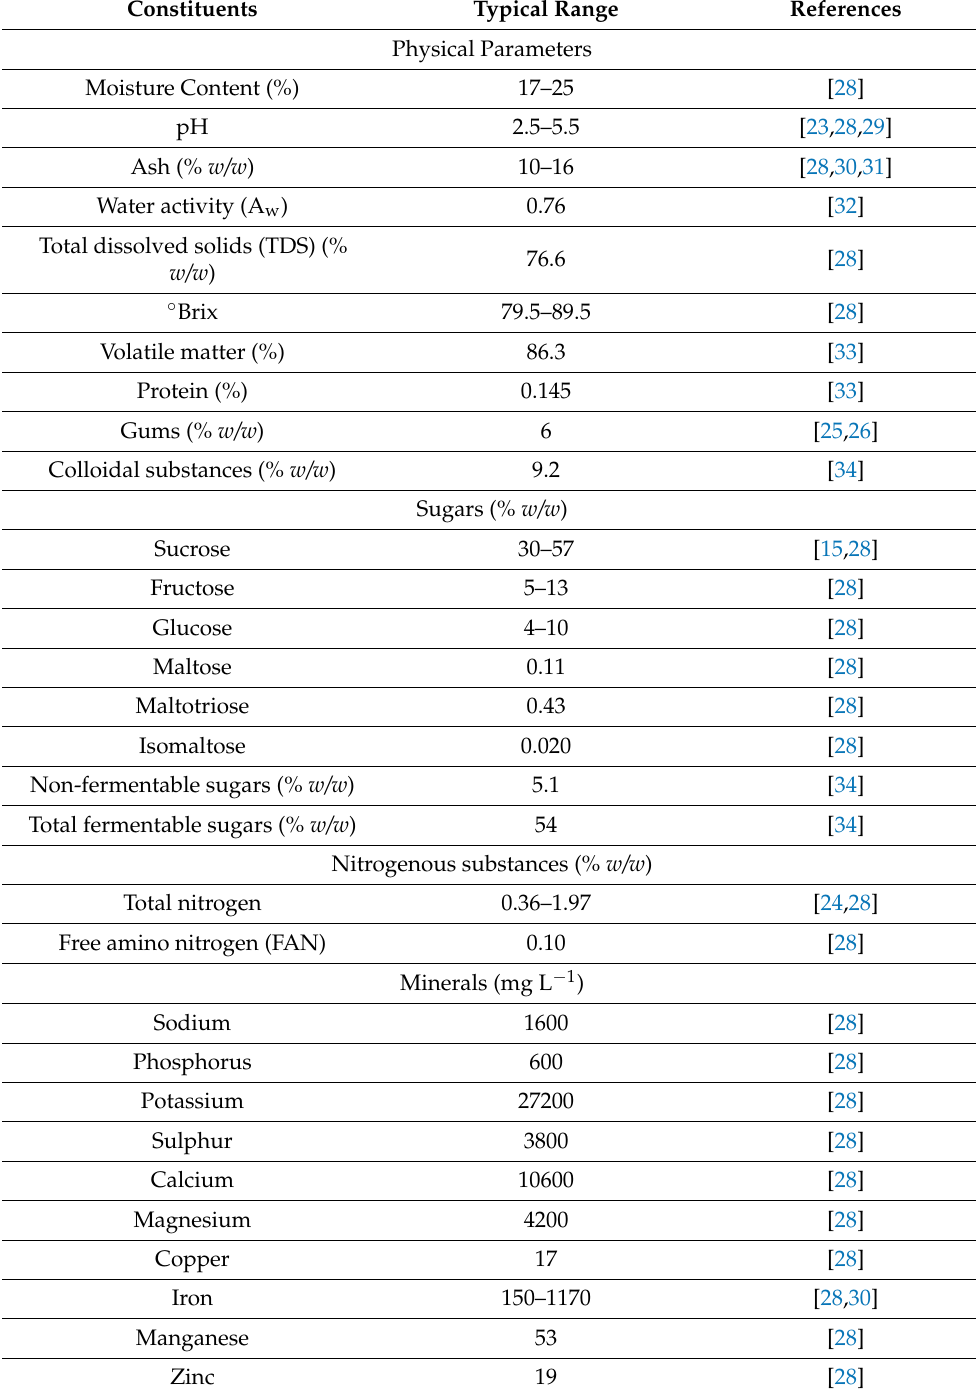
Table 2. Typical physical and chemical composition of sugar cane molasses. Note that the data provided here are for molasses in general, not that specifically used in rum